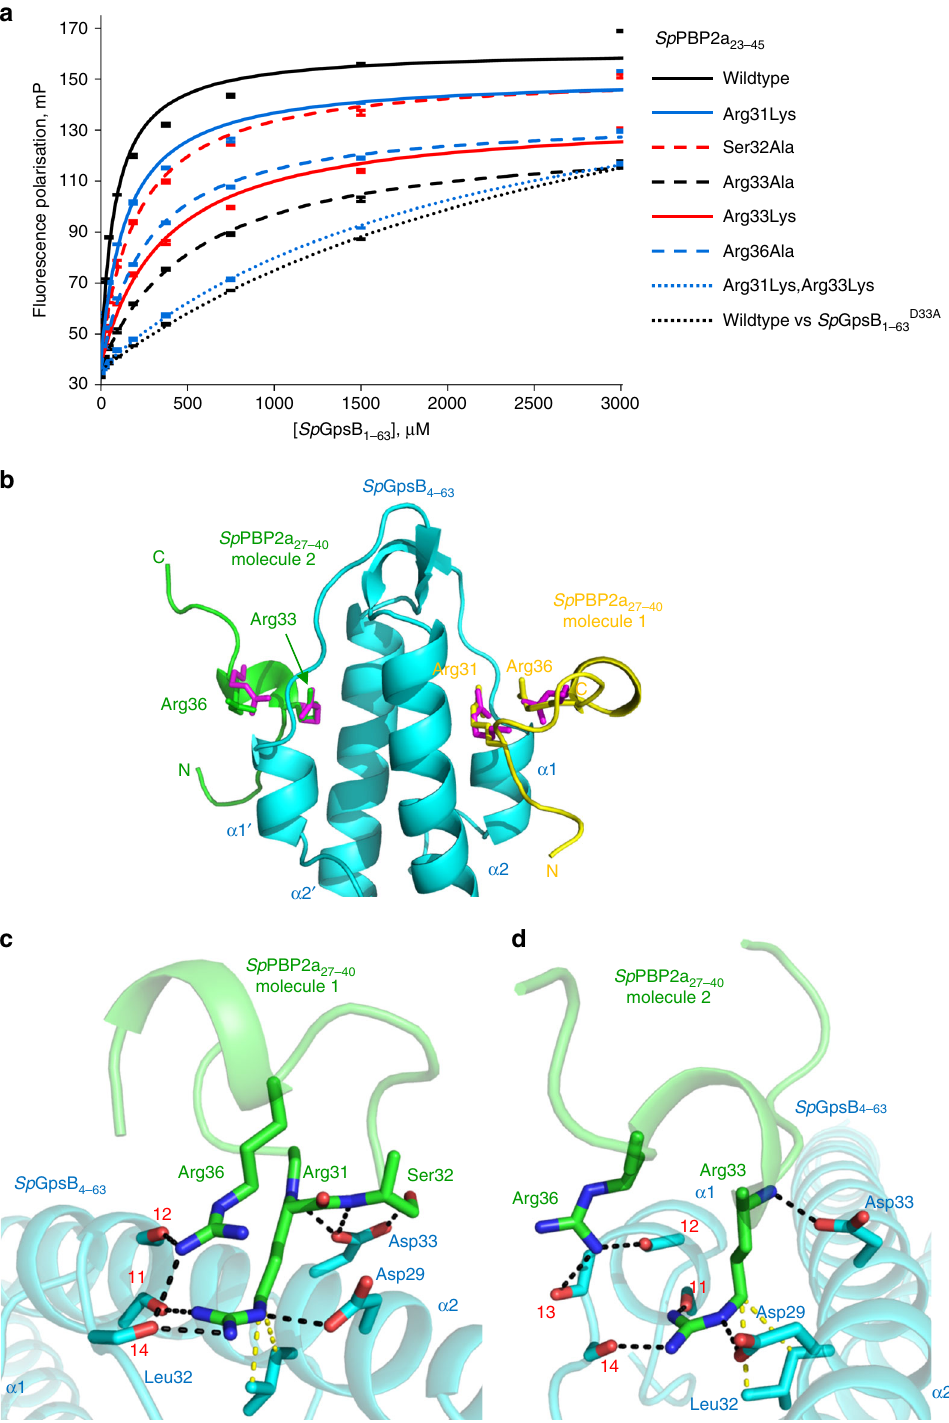
Fig. 4 The Sp PBP2a minidomain is not α -helical but still interacts with Sp GpsB through conserved arginines. a Arginine residues of Sp PBP2a play a key role in binding to Sp GpsB. Unless otherwise indicated, the fl uorescence polarisation binding curves represent the interaction of TAMRA-labelled Sp PBP2a 23-45 peptides with wildtype Sp GpsB 1-63 . The relevant dissociation constants are listed in Supplementary Table 1. b The structure of the Sp GpsB 4-63 : Sp PBP2a 27-40 complex reveals the critical role of Sp PBP2a arginines for the interaction with Sp GpsB. In this cartoon, Sp GpsB 4-63 is coloured cyan, and the Sp PBP2a 27-40 peptide is coloured yellow (molecule 1) and green (molecule 2). The sidechains of Arg8 and Arg11 from the Bs GpsB 5-64 : Bs PBP1 1-17 complex are shown as red sticks after a global superimposition of equivalent GpsB atoms. In molecule 1, Sp PBP2a Arg31 and Sp PBP2a Arg36 superimpose with Bs GpsB 5-64 Arg8 and Bs GpsB 5-64 Arg11 whereas molecule 2 accommodates Sp PBP2a Arg33 and Sp PBP2a Arg36 . c , d Close-up view of the interactions of Sp PBP2a from molecule 1 ( c ) and 2 ( d ) with Sp GpsB 4-63 . Key interfacial sidechains and backbone atoms are represented in stick format; Sp GpsB 4-63 is coloured cyan and Sp PBP2A 27-40 is coloured green. The van der Waals ’ interactions between Sp GpsB Leu32 and Sp PBP1 Arg31 (molecule 1) and Sp PBP1 Arg33 (molecule 2) are in yellow. The carbonyl oxygens of Sp GpsB Ile11 , Sp GpsB Phe12 , Sp GpsB Glu13 and Sp GpsB Gln14 are denoted by respective red